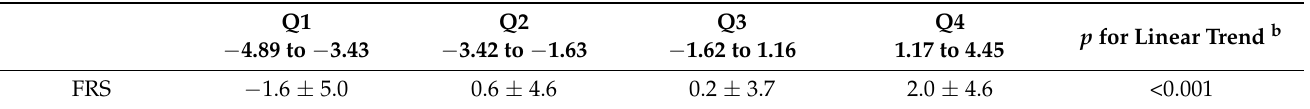
Table 5. The associations between E-DII score quartiles and Framingham risk score (FRS) among the 276 women participants a . Q1 Q2 Q3 p for Linear Trend b − 4.89 to − 3.43 − 3.42 to − 1.63 1.17 to 4.45 FRS − 1.6 ±